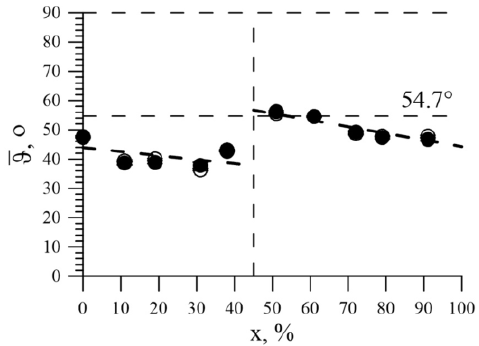
Figure 11. Concentration dependence of the average angle ϑ between the magnetic moments of Fe and the axis of nanotubes, obtained as a result of the restoration of distribution of hyperfine magnetic field ( ○ ) and the model interpretation.